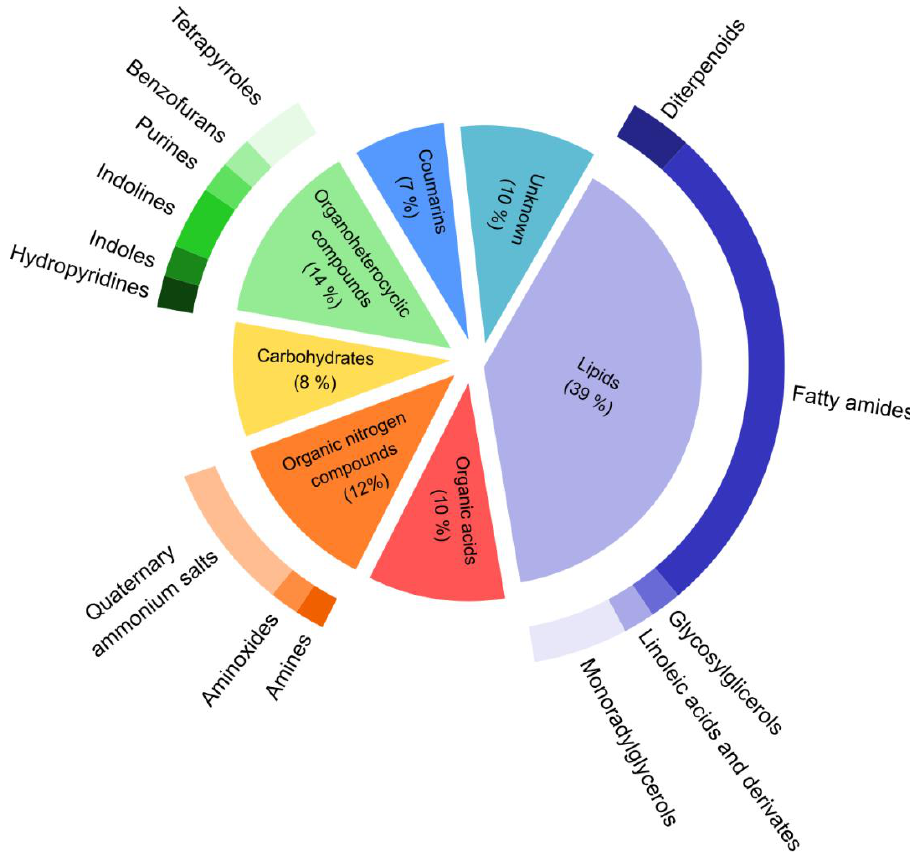
Figure 4. Chemical classification of compounds identified at low temperature (12 °C). Structural classification of metabolites differentially accumulated between populations with high and low glucosinolates content at cold (12 °C) computed using the ClassyFire web-based application.